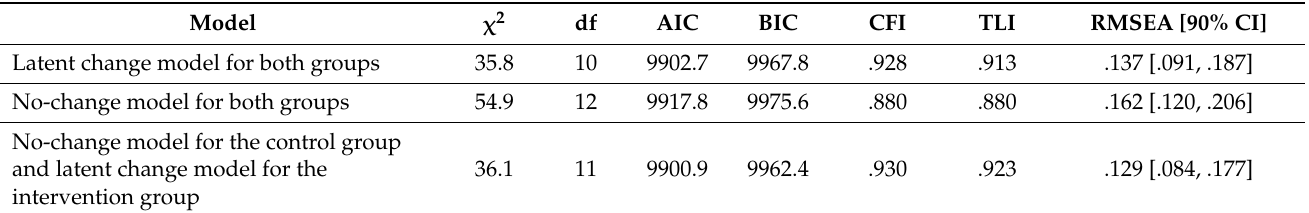
Table 7. Goodness-of-fit indices for the models tested on the test level in the first dimension (devel- opment between the pre- and